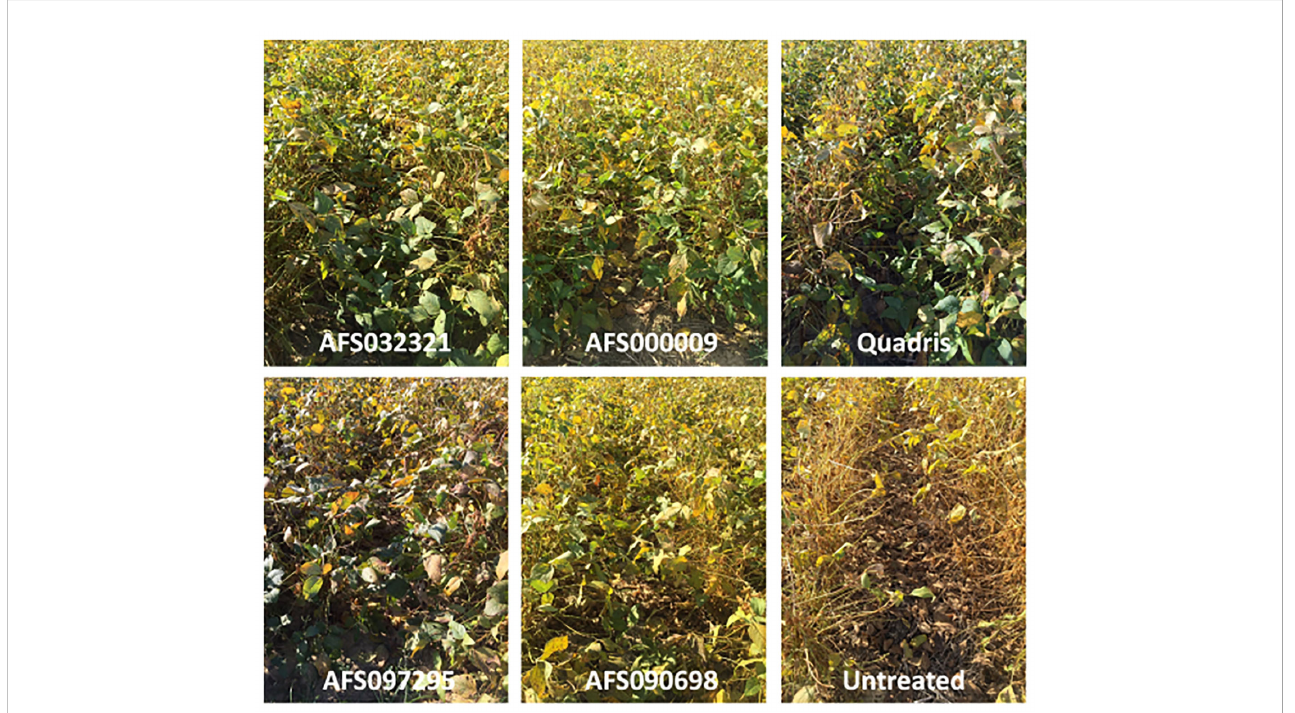
FIGURE 5 Rust symptoms observed on soybean plants (R6 or R7 growth stages) from the fi eld trial conducted at the Gulf Coast Research and Extension Center (GCREC) in Fairhope, Alabama. Included in this fi gure are pictures of soybean plots that were treated with four bacterial strains AFS000009